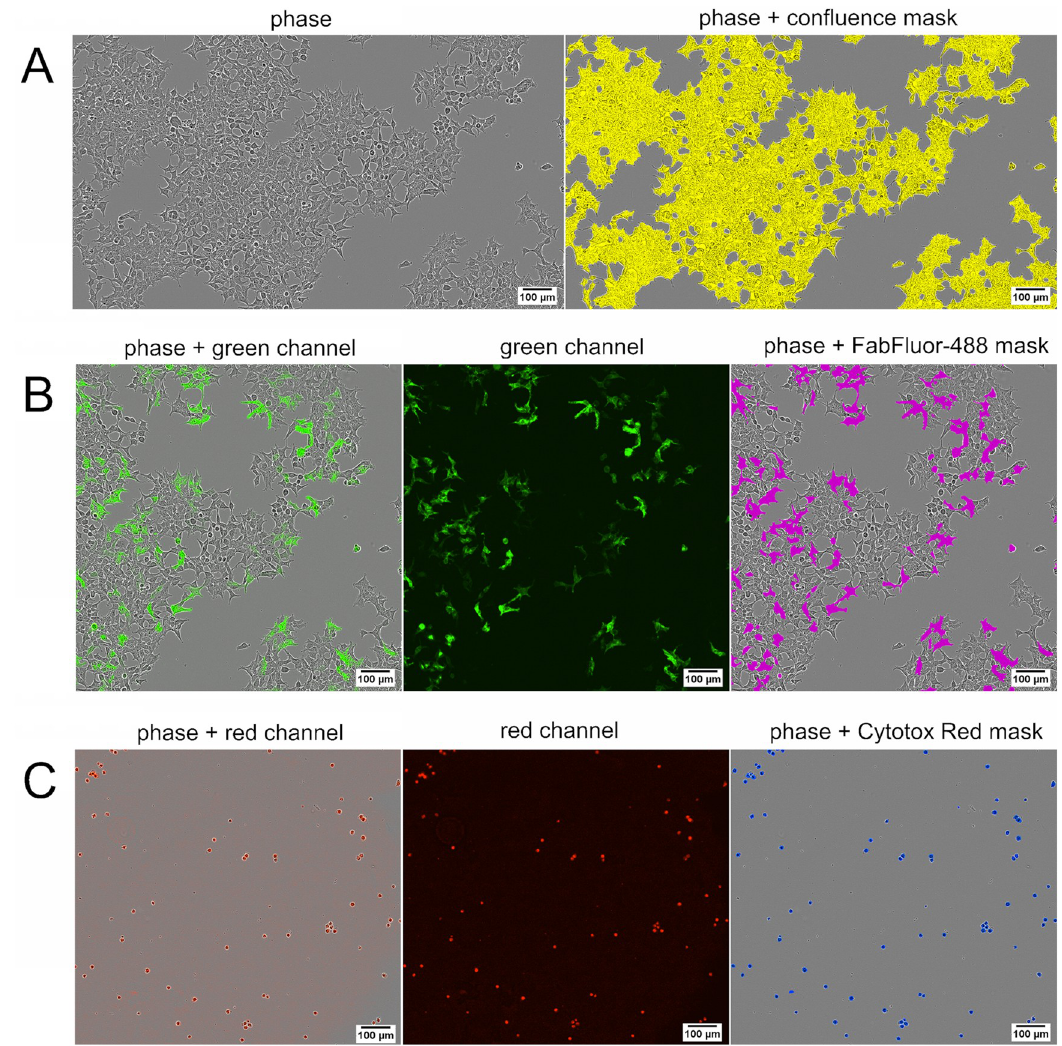
Fig 3. Detection masks for infective titer calculation. (A) Phase contrast image of HEK293T cells (left), merged with phase contrast area analysis mask in yellow (right). (B) HEK293T cells infected with lentiviral vector at a 1:625 dilution. The expressed CAR-construct was stained with an anti-FMC63 scFv antibody labeled with FabFluor-488. Phase contrast image merged with green fluorescence channel (left), background corrected green fluorescence channel (middle), and phase contrast image merged with green fluorescence analysis mask in magenta (right). (C) Live/dead staining positive control cells treated with 0.005% Triton X-100 and stained with Cytotox Red. Phase contrast image merged with red fluorescence channel (left), background corrected red fluorescence channel (middle), and phase contrast image merged with red fluorescence analysis mask in blue (right). All images were taken at 10x